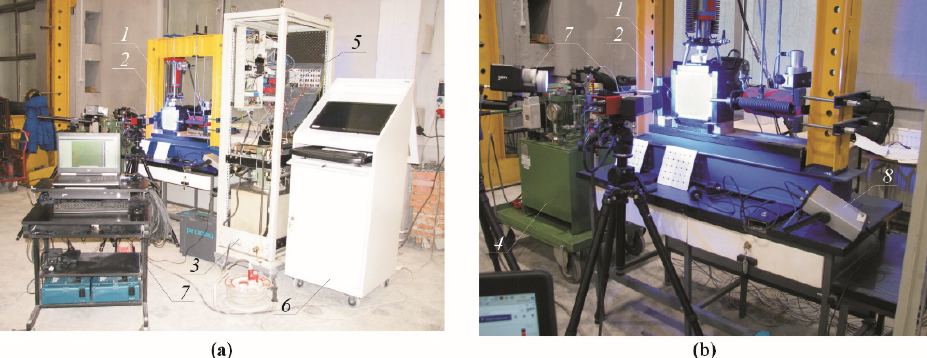
Figure 4. Measurements of ultrasonic wave velocity in biaxially compressed specimens: ( a ) com- ponents of stress states and the position of the measuring template; ( b ) geometry of the measuring template; ( c , d ) the test specimen; ( e ) the exponential transducer; 1–the AAC specimen 180 mm × 180 mm × 120 mm, 2 –exponential transducers, 3 –cables connecting transducers with recording equipment, 4 –the measuring template, 5 –PUNDIT LAB+ recording equipment.